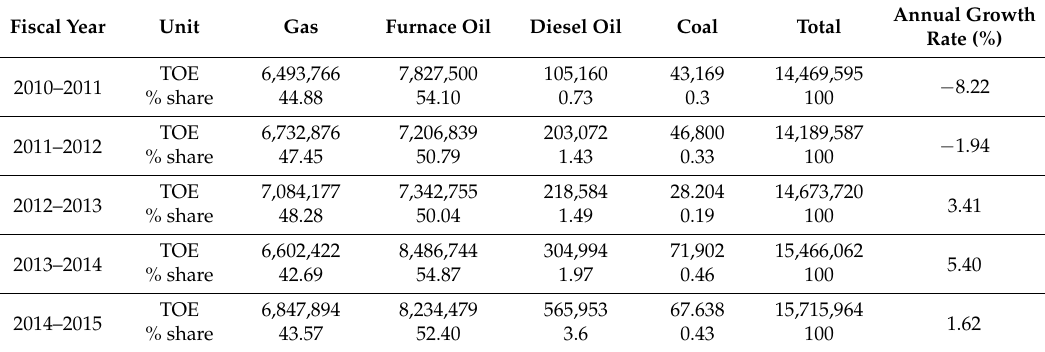
Table 5. Fuel consumption for thermal power production in tons of oil equivalent (TOE).